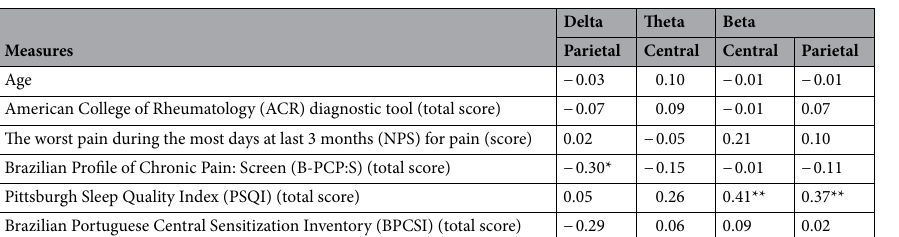
Table 4. Pearson’s correlations between peak amplitudes (variations between EO-EC states), age, pain-related symptoms, sleep quality and psychophysical pain assessment (total n = 47). Measures of EEG are based on EO-EC variation of peak amplitudes. * p < 0.05; ** p <